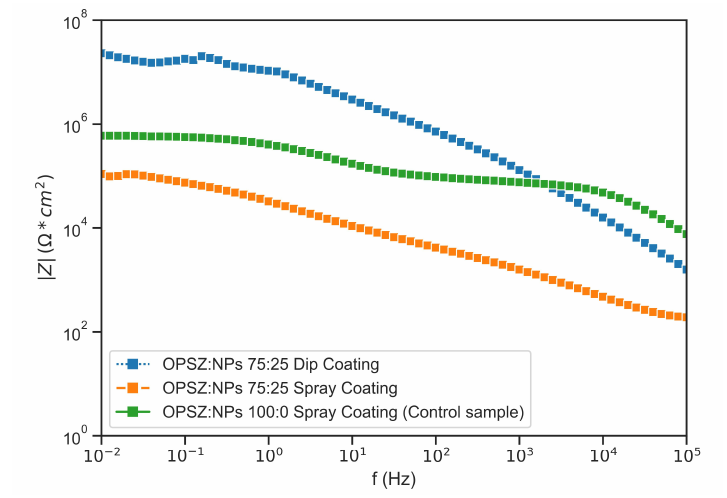
Figure 12. Bode modulus.